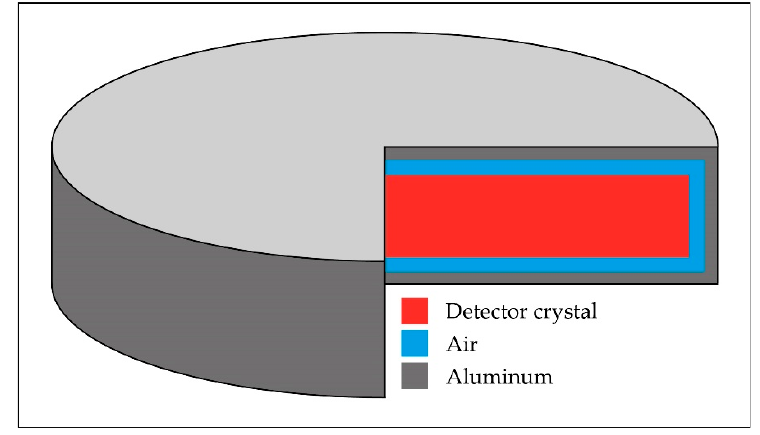
Figure 2. Schematic of the simulated detector geometry (not to